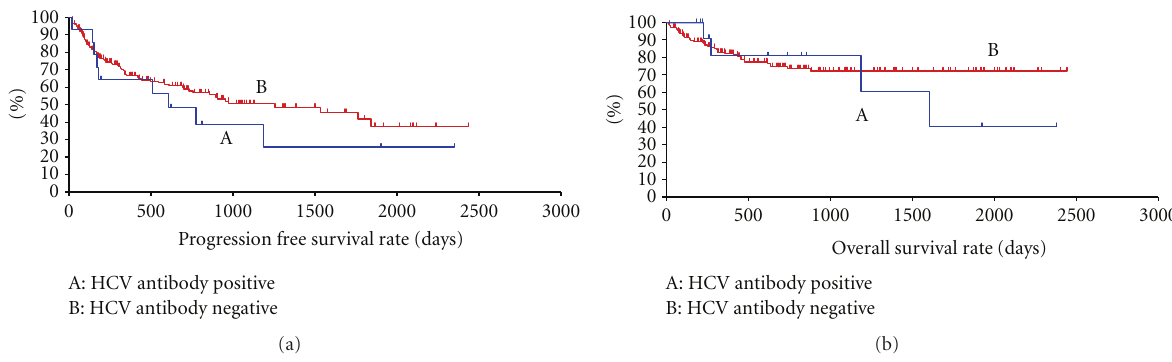
Figure 3: Progression free survival (a) and overall survival (b) curves of non-Hodgkin’s lymphoma patients who were anti-HCV-antibody negative (B) and anti-HCV antibody positive (A). Both survival parameters were lower in anti-HCV antibody positive patients, however, no significant di ff erence was seen when comparing these two